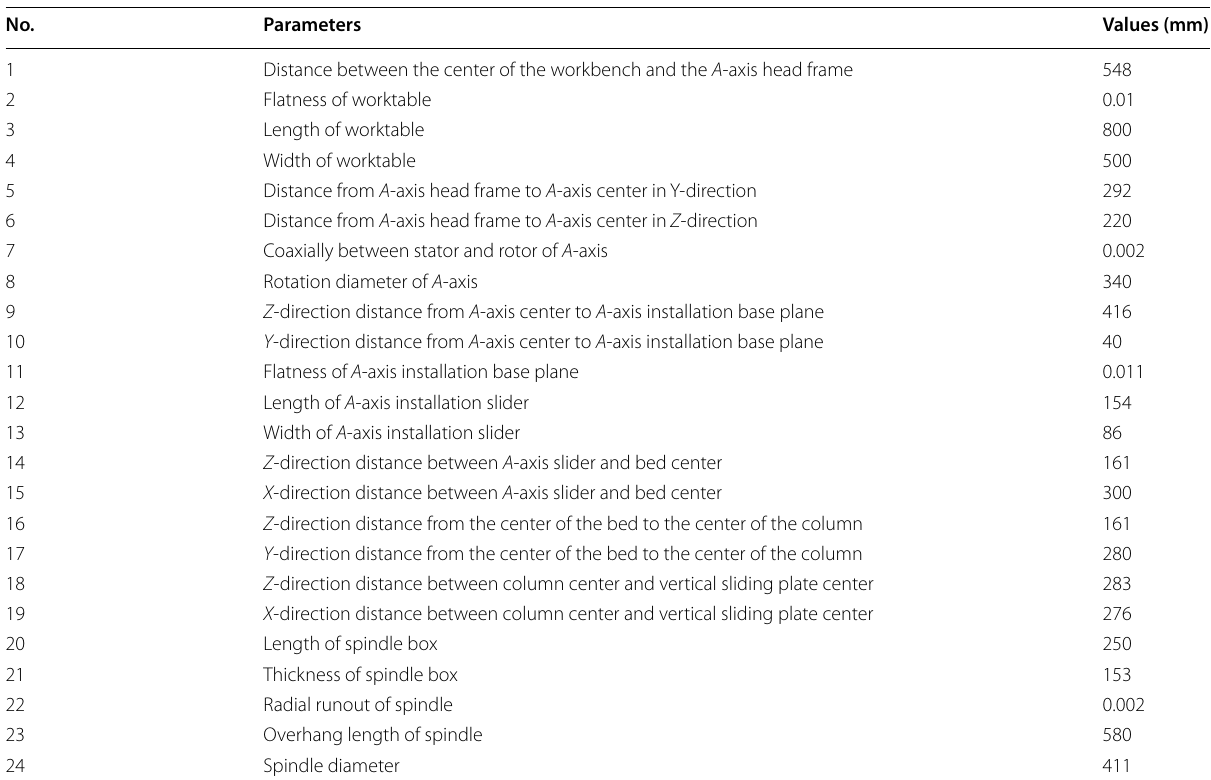
Table 3 The detail parameters of the machine tool